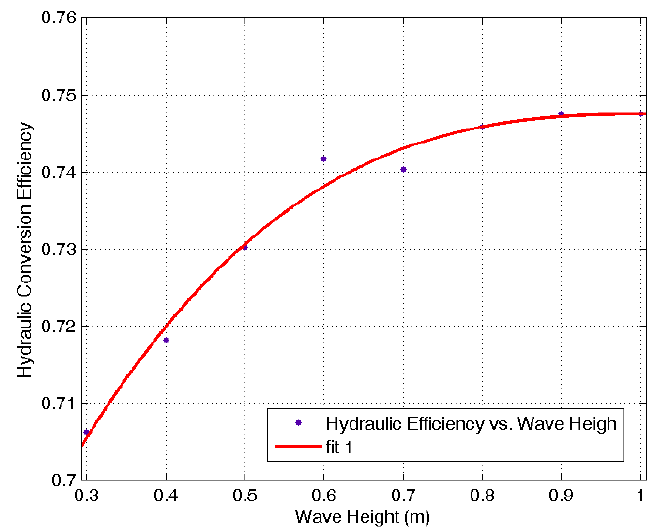
Figure 6. The wave height  hydraulic conversion efficiency curve of this WEC. Figure 6. The wave height–hydraulic conversion efficiency curve of this